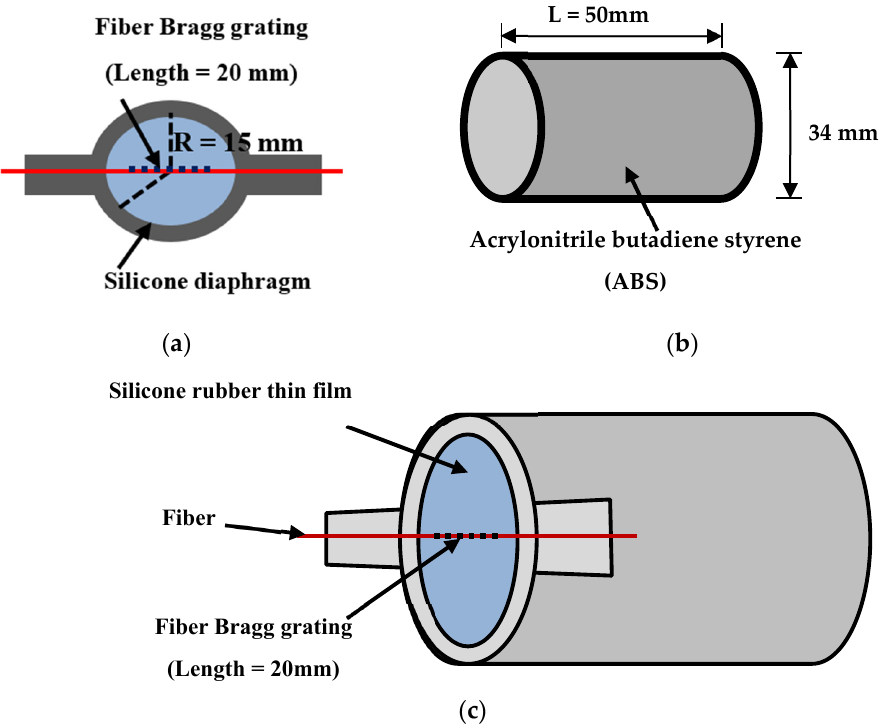
Figure 1. The FBG hydrophone configuration including ( a ) the silicon diaphragm, ( b ) the frame of acrylonitrile butadiene styrene, and ( c ) the FBG hydrophone composed of ( a , b ).